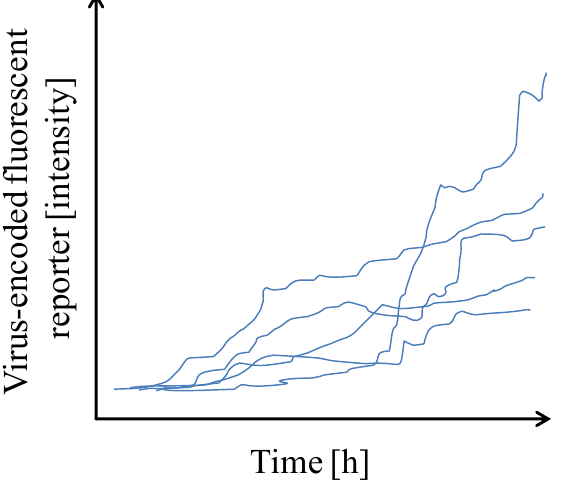
Figure 1. Single cells display cell-to-cell variability in gene expression. Graph plot showing the expression of a virus-encoded fluorescent reporter over time post-infection as quantified by time-lapse microscopy. (Adapted from